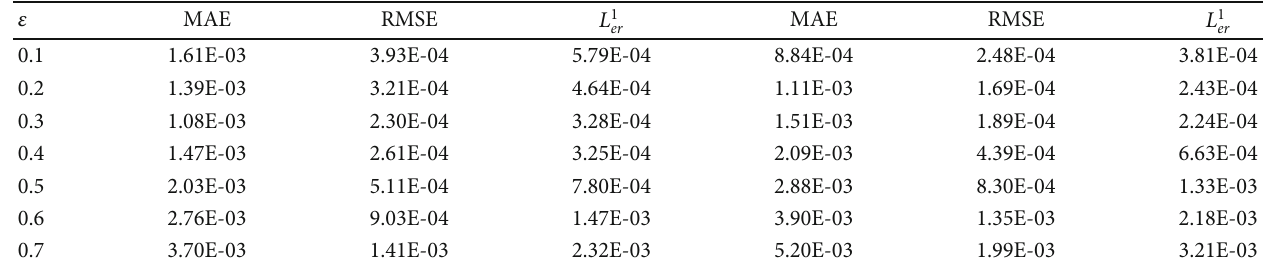
Table 9: Results for di ff erent values of ε in Example 2 with N